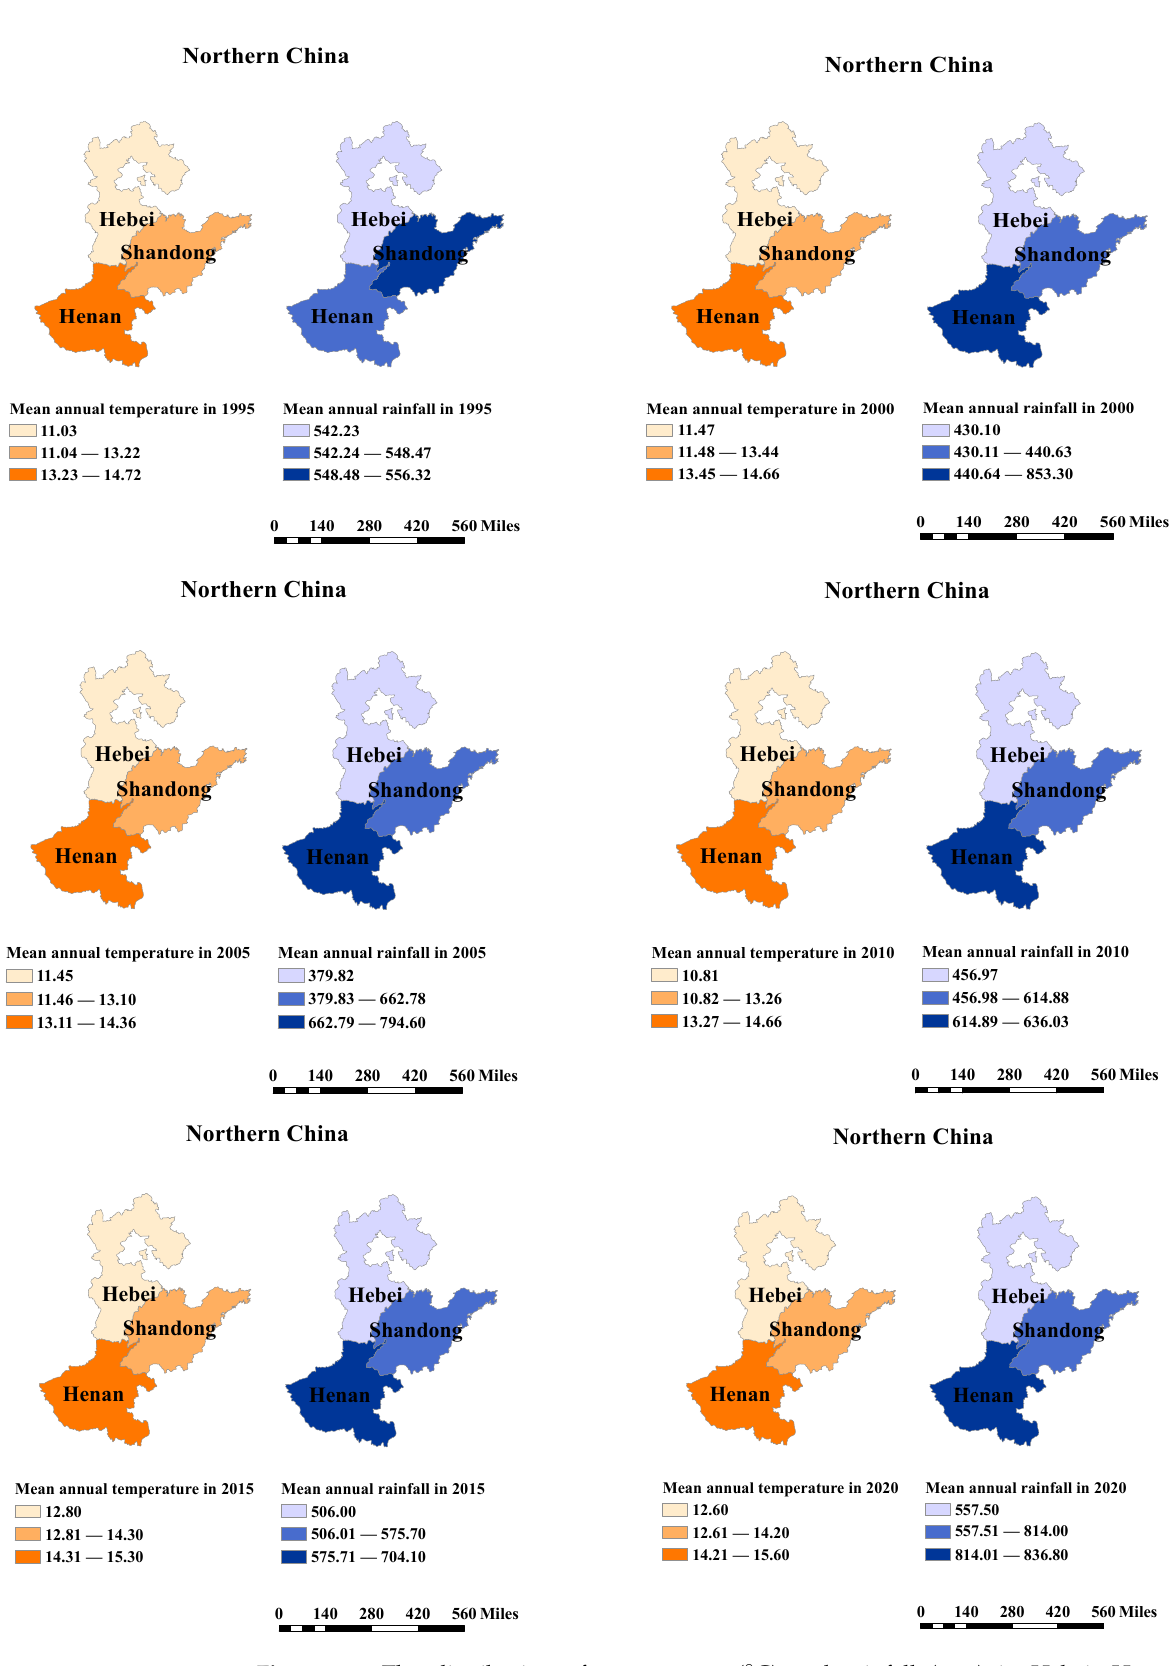
Figure 2. The distribution of temperature (°C) and rainfall (mm) in Hebei, Henan, and Shandong Provinces.